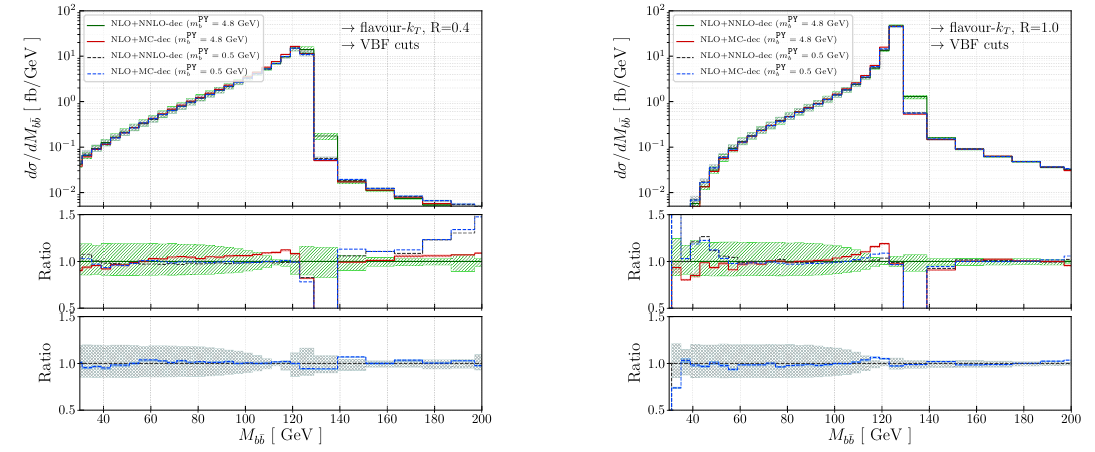
Figure 8 . Invariant mass of the two b -jets in VBF Higgs events with Higgs decaying to b -quarks. The VBF cuts described in section 4.2 are applied. The jets are reconstructed with the (cid:13)avour algorithm of ref. [52] for R = 0 : 4 (left) and R = 1 : 0 (right). The plots show the dependence of the results when approaching the small b -quark mass in Pythia8 , see text for details.